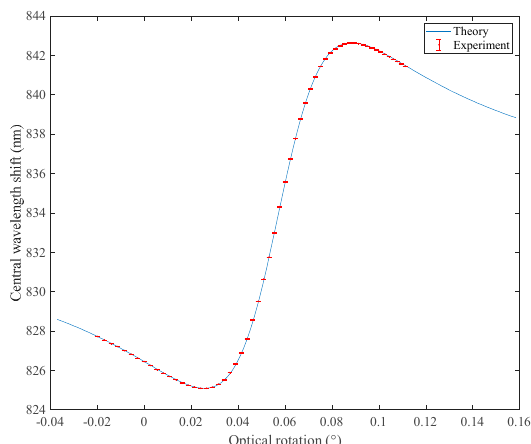
Figure 2. A simulation curve and experimental results of the central wavelength as a function of system optical rotation are obtained by adjusting the angle of the pre-selected polarizer.